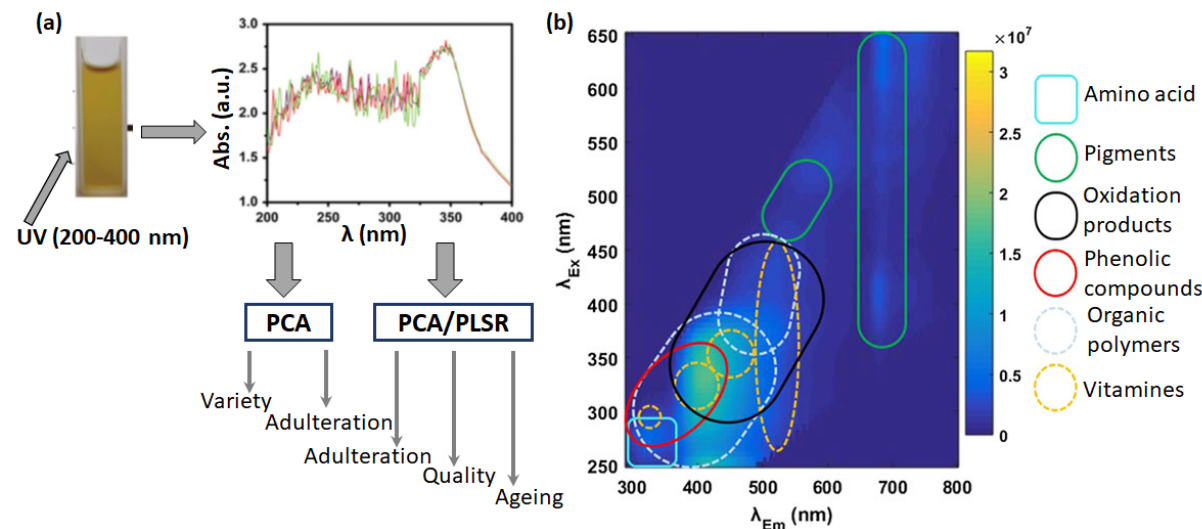
Figure 5. Schematic illustration of apple juice analysis by UV ‐ Visible absorption spectroscopy and analysis of its data by chemometrics to predict variety, adulteration, quality, and ageing. The spectra of the juices derived from four different apple varieties are compared in different colors. ( a ). Adapted from ref. [60]. Mapping of fluorophores present in different chemical compounds in a fruit sample, performed by front ‐ face fluorescence spectroscopy with excitation wavelengths of 250–650 nm and emission wavelengths of 290–800 nm. The region with a dark blue color indicates absence, while the region with a yellow color marks the presence of fluorophores, respectively ( b ). Adapted from ref. [66].